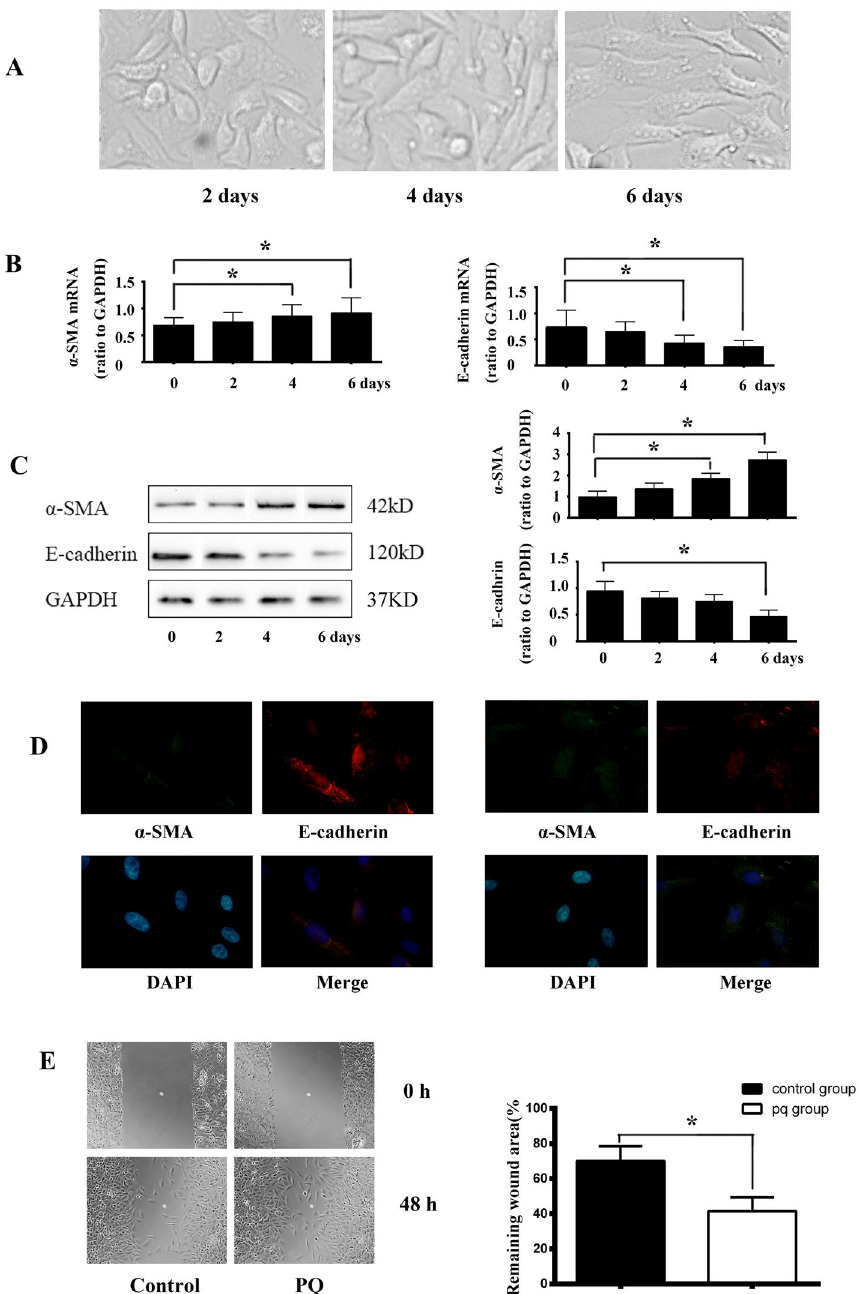
Figure 1. PQ induced EMT-like phenotypic changes in A549 cells. ( A ) Morphological changes of A549 cells induced by PQ exposure (300 μ mol/L) at different time points. After exposure to PQ, the cells gradually displayed morphological appearances of mesenchymal cells and after 6 days of PQ exposure, the majority of cells became spindle-shaped. ( B ) Quantitative RT-PCR analysis result of α -SMA and E-cadherin mRNA in A549 cells after exposure to PQ at indicated time points. PQ treatment induced increasing of mRNA of α -SMA and decreasing of E-cadherin after 4 days of exposure. The qRT-PCR results shown represent an average of three independent experiments. ( C ) Alterations of α -SMA and E-cadherin proteins expression in PQ treated A549 cells in serials of time by Western blot analysis. A dramatic decrease of E-cadherin protein was detected on the 6th days and an increase of α -SMA protein level on the 4th day after PQ exposure. Representative blots from three independent experiments are shown. Density of α -SMA and E-cadherin were quantified and expressed as the ratio to GAPDH. ( D ) Increased cell membrane distribution of α -SMAprotein and decreased E-cadherin proteininA549cells in respond to PQ stimulation as assessed by immunofluorescent staining. α -SMA was stained green, E-cadherin was stained red and DAPI stained nuclei blue. ( E ) A significantly increased migration capacity after PQ exposure by about 0.41 fold was calculated than that of normal A549 cellsby monolayer wound-healing assay. * p <